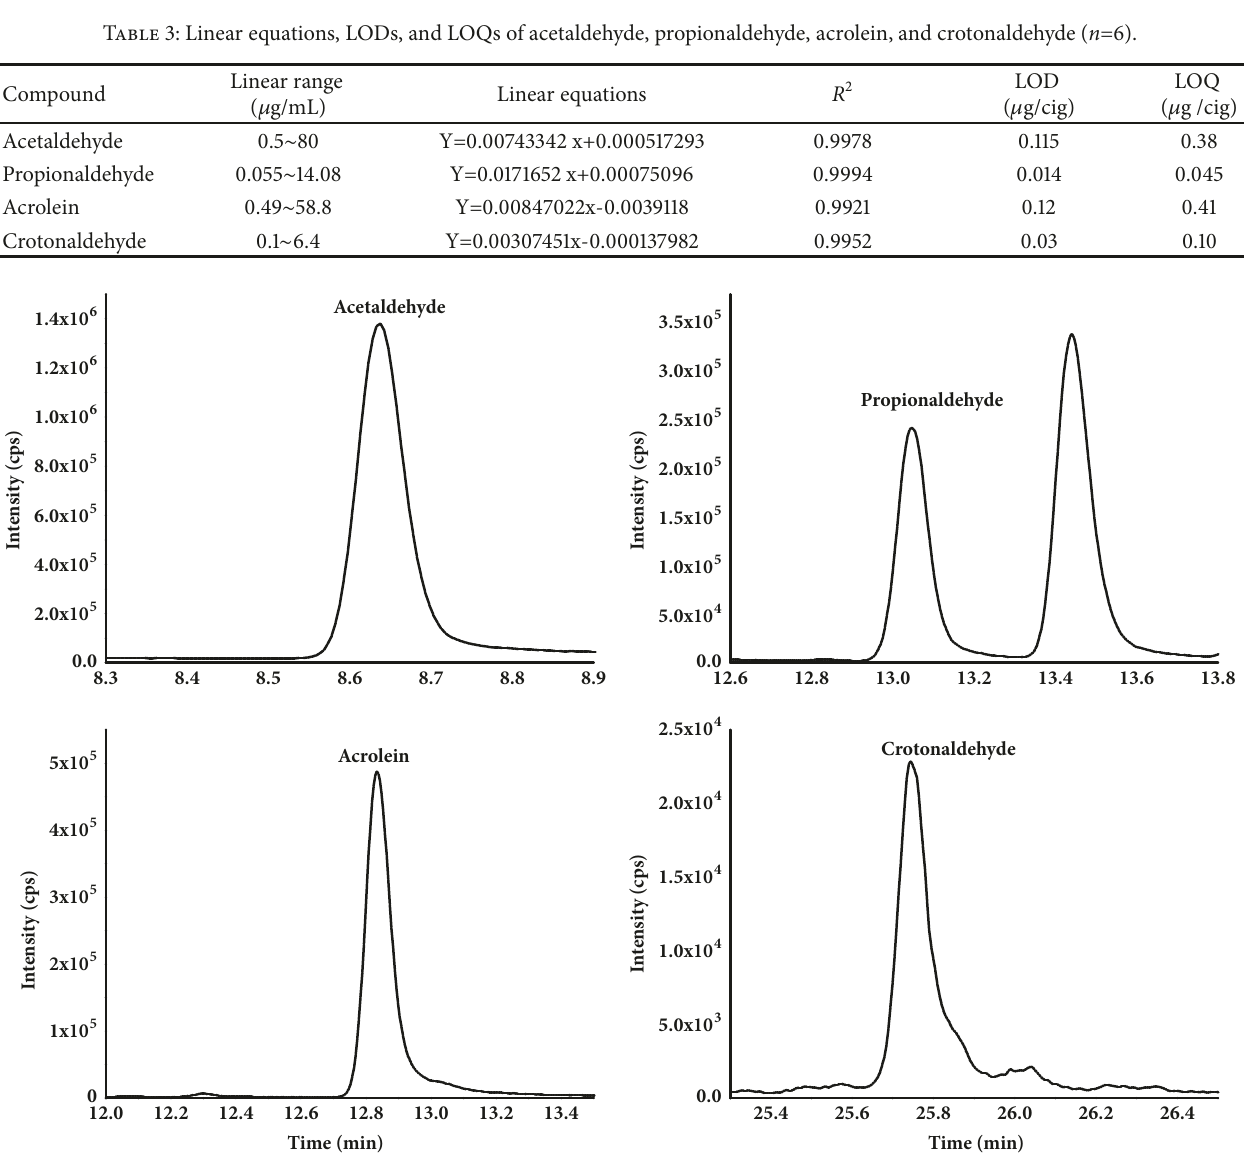
Figure 2: Extraction ion chromatograms of acetaldehyde, propionaldehyde, acrolein, and